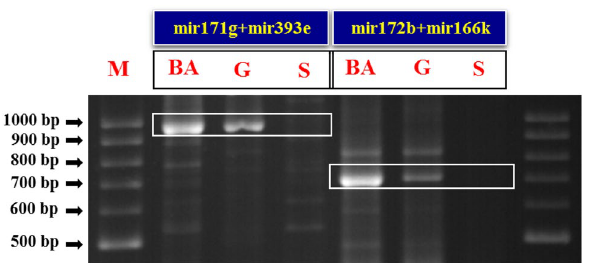
Figure 2. PCR amplification profile generated with selected miRNA-based markers including mir171g + mir393e (nucleotide length of around 990 bp) and mir172b + mir166k (nucleotide length of around